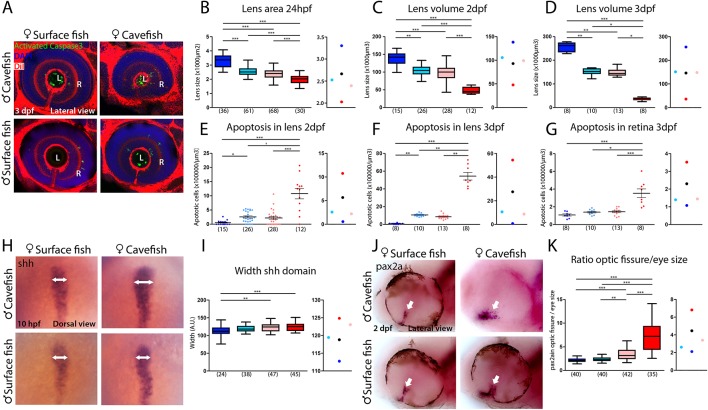
Maternal effect on eye development.(A) Immunostaining of activated caspase three in the developing eye at 3 days post-fertilization (dpf). (B–D) Quantification of the size of the lens at 24 hpf (B, area), 2 dpf (C, volume) and 3 dpf (D, volume). (E–G) Quantification of the number of apoptotic cells per unit of volume in the lens at 2 dpf (E) and 3 dpf (F) and in the retina at 3 dpf (G). (H) Expression of Shh at 10 hpf. (I) Quantification of the width of the Shh expression domain (arrows in panel H). (J) Expression of Pax2a in the optic fissure (arrow) at 2 dpf. (K) Quantification of the size (area) of the Pax2a expression domain in the optic fissure normalized by the eye size (area). Embryos are arranged in panels (A, H and J) as follows: HybSF (top left), cavefish (top right), surface fish (bottom left) and HybCF (bottom right). In the quantifications, HybSF, cavefish, surface fish and HybCF are colored light blue, red, blue and pink, respectively. A plot of means is shown to the right of each graph. Images in panels (A) and (J) correspond to lateral views of the eye, anterior to the left. Images in panel (H) are whole-mounted embryos in dorsal views, anterior to the top. Kruskal-Wallis tests with Dunn’s post-test were performed in all cases.